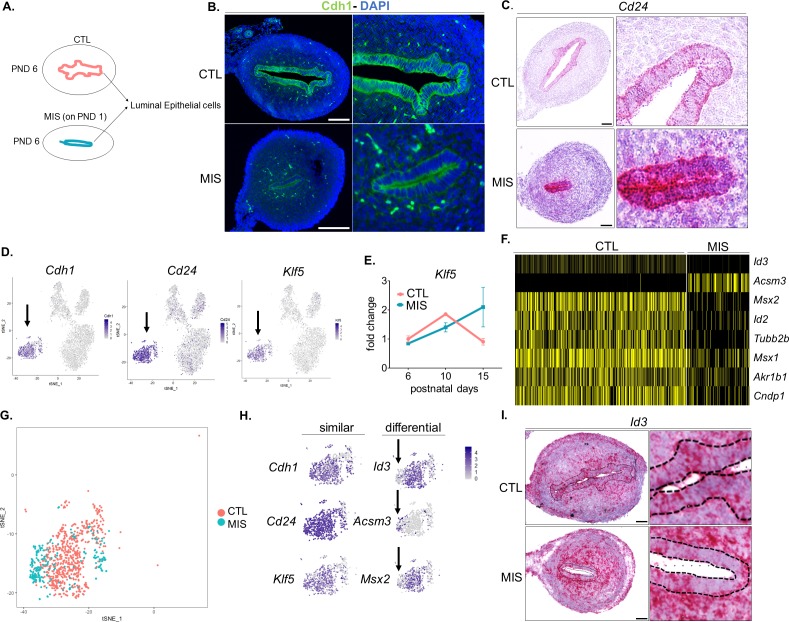
Single-cell RNA sequencing reveals the gene signature of uterine epithelial cells and a non-cell autonomous response to MIS.Rat or mouse pups were injected with empty vector control (CTL) or with AAV9-MIS (MIS) on PND 1 and analyzed at different time points (A–D). (A) Representative schema of the CTL (orange) and MIS-treated (blue) rat uteri at PND 6. (B) Immunofluorescence of Cdh1 on control and MIS-treated mouse uteri at PND6. Scale bars = 50 µm. (C) RNAish analysis of Cd24 (one of the top epithelial markers of Table 1) in control and MIS-treated rat uteri at PND6. Scale bars = 50 µm. (D) Cdh1, Cd24, and Klf5 expression pattern in t-SNE plots. Black arrows indicate the luminal epithelial cell cluster. (E) QPCR analysis of Klf5 in control and MIS-treated tissue. CTL (orange), MIS (blue). (F) Heatmap of differentially expressed genes in CTL and MIS-treated luminal epithelium (Figure 4—source data 2). (G) T-SNE plot of unbiased clustering of uterine luminal epithelial cells (dots) color-coded by treatment with CTL (orange) and MIS (blue). Note that the CTL and MIS-treated cells have distinctive sub-clustering pattern. (H) Further analysis of the commonly (Cdh1, Cd24, and Klf5) and differentially (Id3, Acsm3, and Msx2) expressed luminal epithelial genes from the T-SNE plots. (I) Id3 expression pattern by RNAish in control and MIS-treated uteri. Dotted lines demarcate the luminal epithelium. Scale bars = 50 µm.